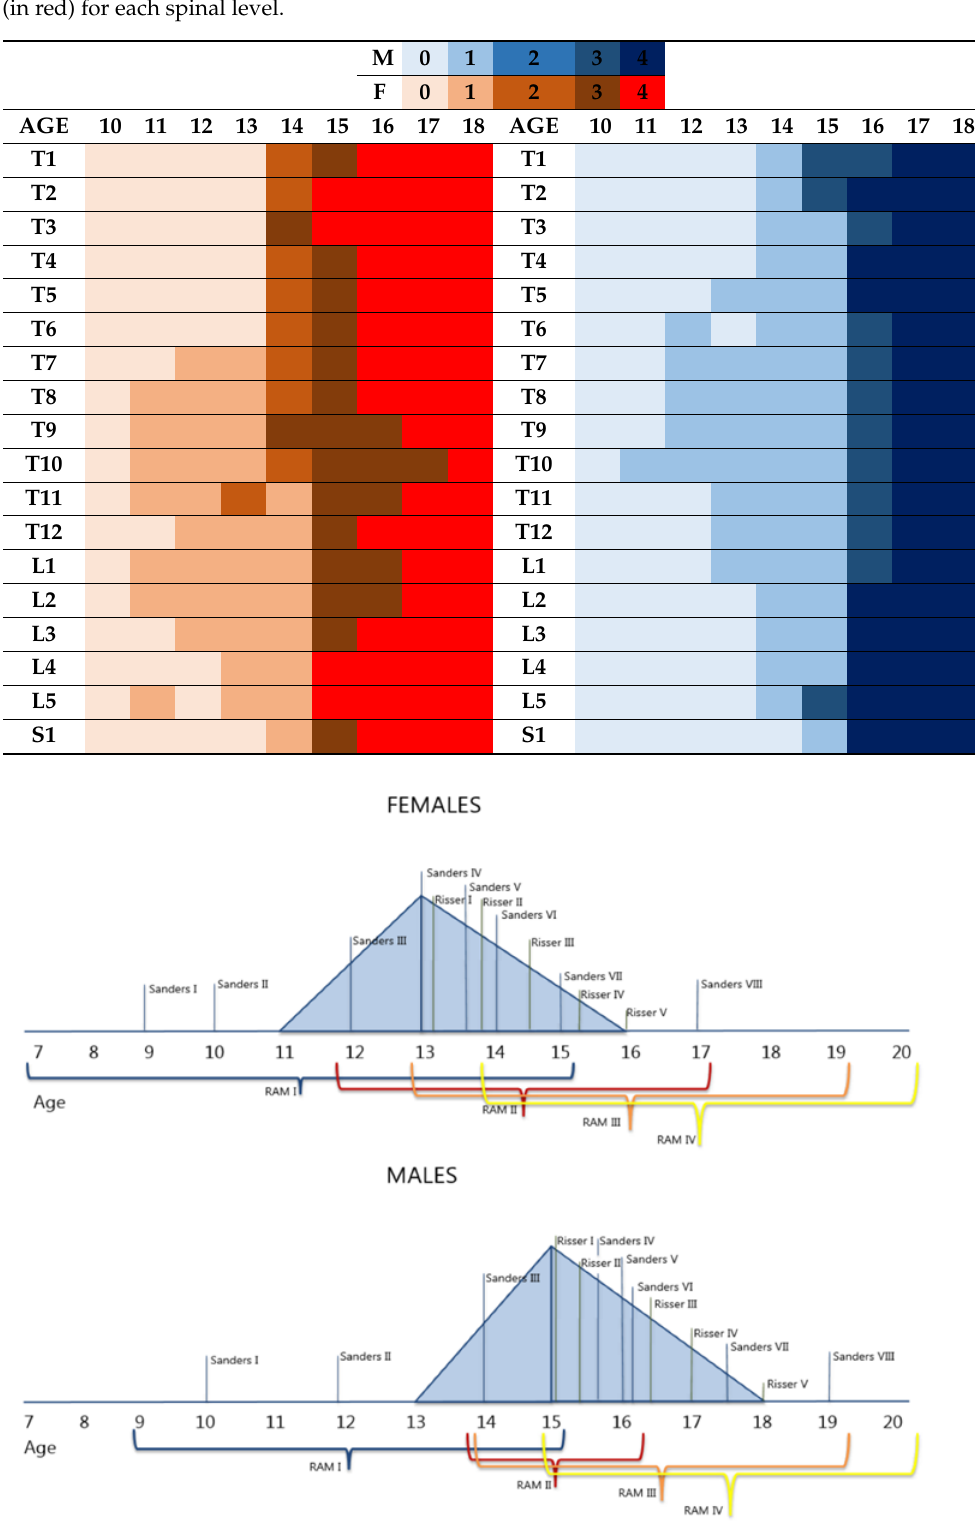
Figure 5. Figure based on Di Meglio et al. (2011) in which Sanders, Risser, and RAM classifications are correlated to growth velocity (and peak height velocity) in females and males [22].